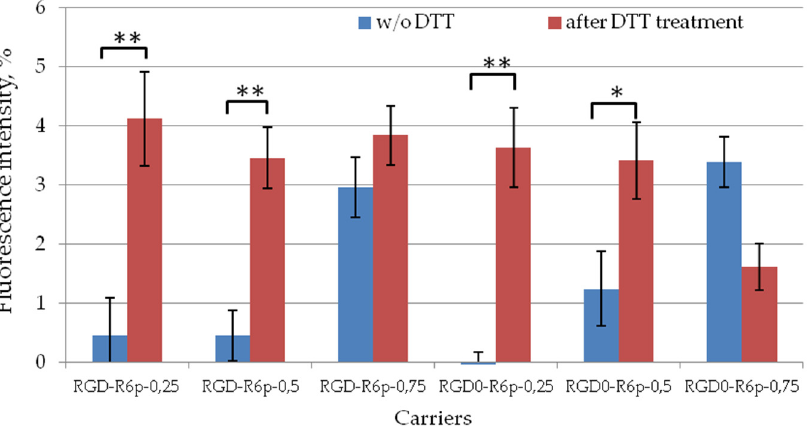
Figure 4. DNA release after DTT treatment of DNA polyplexes. Values are the mean ± SEM of the mean of triplicates. * p < 0.05, ** p < 0.01 compared to untreated complexes.